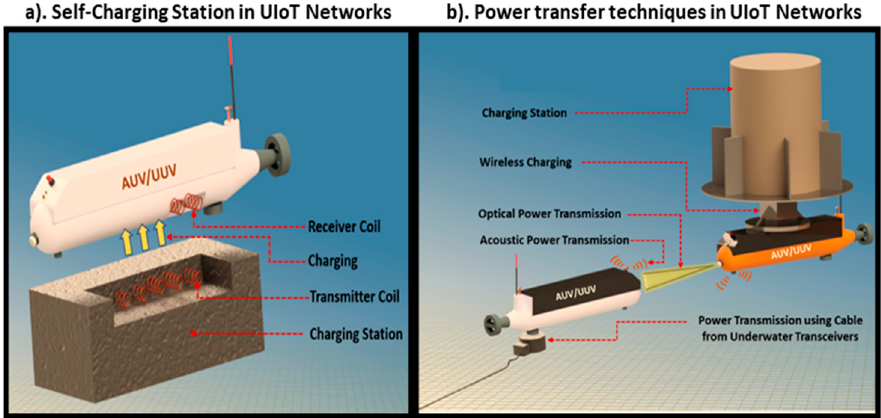
Figure 5. ( a ) Design of AUV self-charging station. ( b ) Types of power transfer methods in UIoT networks .